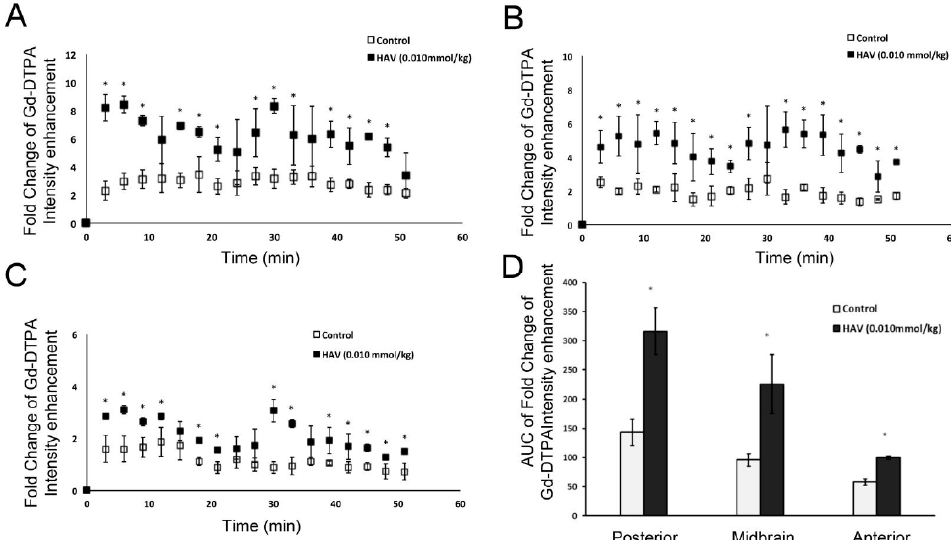
Figure 2. Analysis of pixel intensity for Gd-DTPA from T1-weighted images normalized to the pixel intensity at time 0 of the injection in ( A ) the posterior, ( B ) midbrain and ( C ) anterior regions of the brain. ( D ) Area under the curve for Gd-DTPA obtained from T1-weighted images over the span of 51 min. * p value < 0.05 in comparison to control group. Values represent the mean ± SEM for four mice per treatment group.